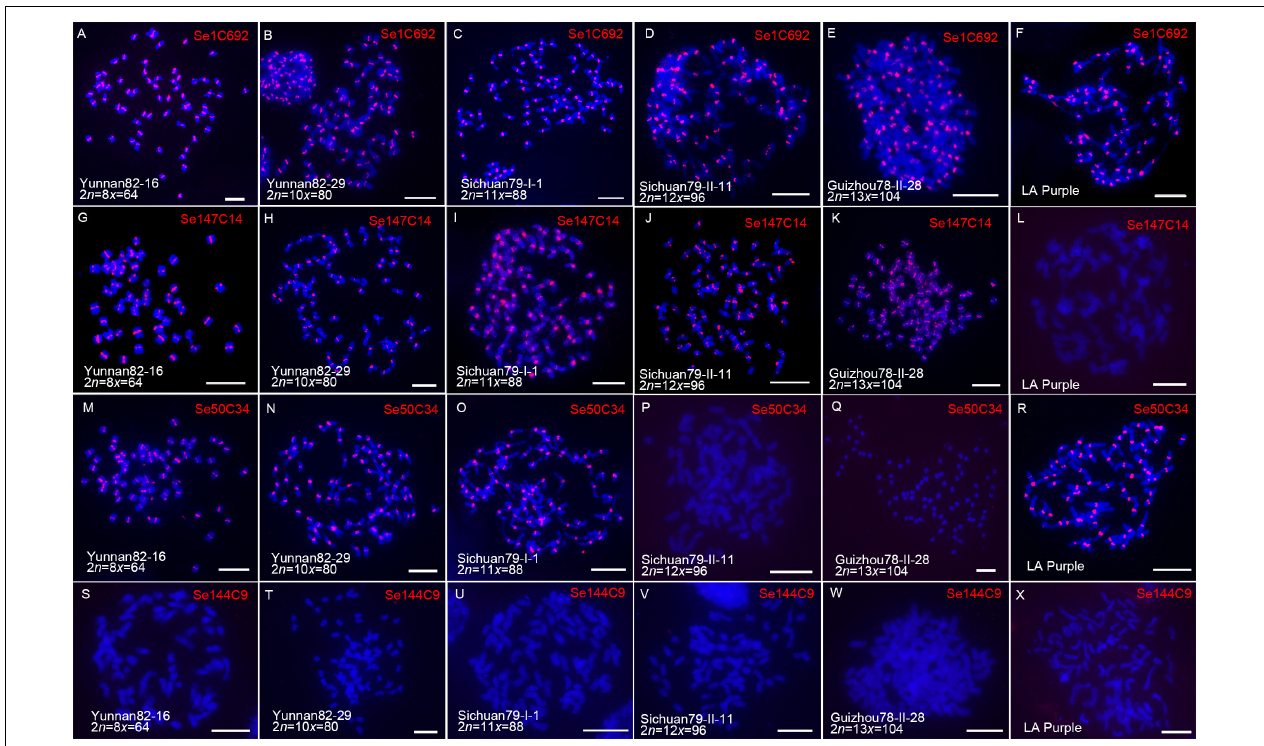
FIGURE 5 | Comparative FISH assay using centromeric retrotransposon-derived repeats in S . spontaneum clones. Five S . spontaneum clones, Yunnan82-16, Yunnan82-29, Sichuan79-I-1, Sichuan79-II-11, and Guizhou78-II-28, and S. officinarum clone LA Purple, were subjected to FISH. FISH images demonstrated that centromeric signals were detected from the probe of Se1C692 in all studied clones (A–F) . For repeat Se147C14 (G–L) , centromeric signals were detected from LA Purple and four S . spontaneum clones Yunnan82-16, Yunnan82-29, Sichuan79-I-1, and Sichuan79-II-11. For repeat Se50C34 (M–R) , centromeric signals were detected from LA Purple and three S . spontaneum clones, Yunnan82-16, Yunnan82-29, and Sichuan79-I-1. Repeat Se144C9 showed no signal in LA Purple and the five studied S. spontaneum clones (S–X)